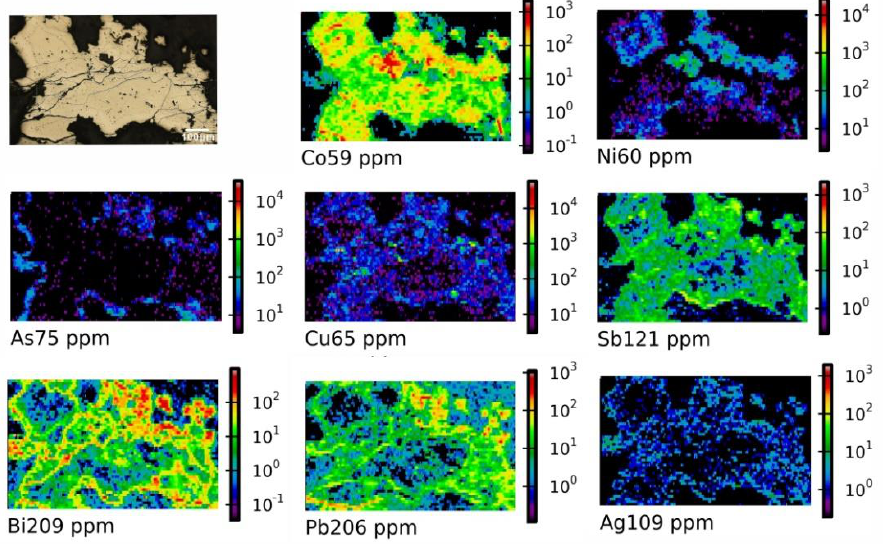
Figure 14. Mapping of pyrite from Sample 490 − 28.